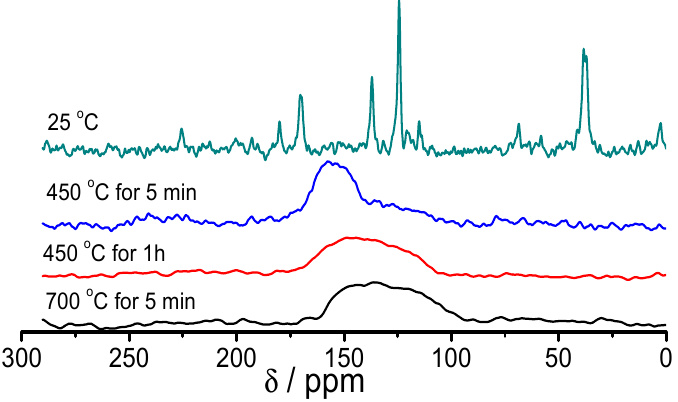
Figure 3. Solid state 13 C-NMR spectra of IL prepared at different holding time and temperatures.